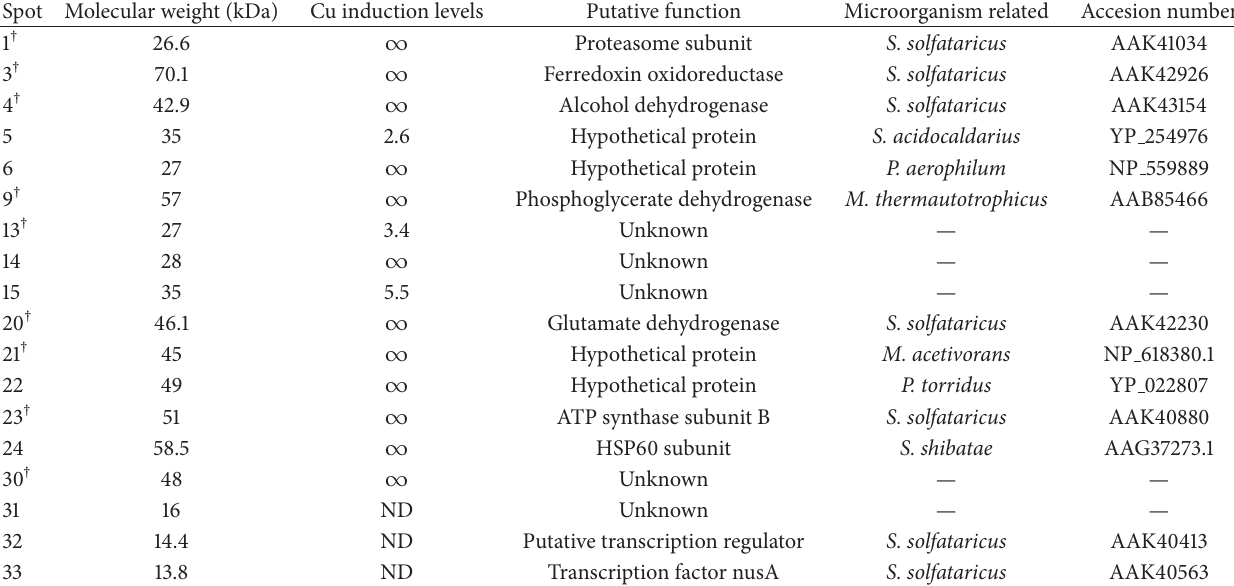
Table 2: Proteins upregulated in S. metallicus cells exposed to 100mM Cu or 1mM